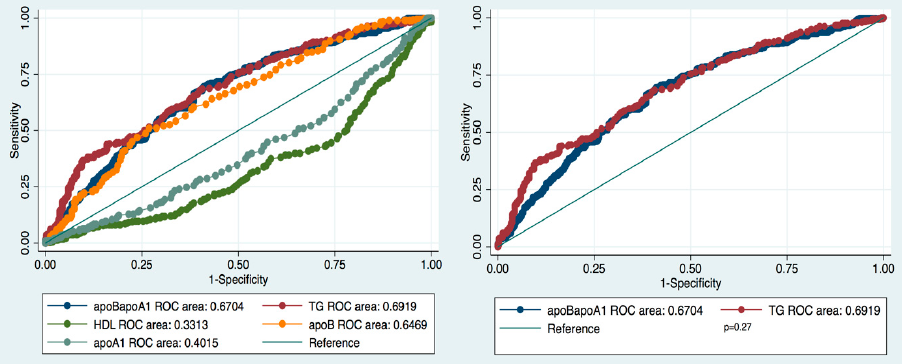
Figure 3. Comparison of ROC curves and AUCs of ApoB/ApoA1, TG, HDL-C, ApoB, ApoA1 for the diagnosis of MS. Table 4. Unadjusted and adjusted ROC areas for TG, ApoB / ApoA1, ApoB, and HDL-C for MS diagnosis.